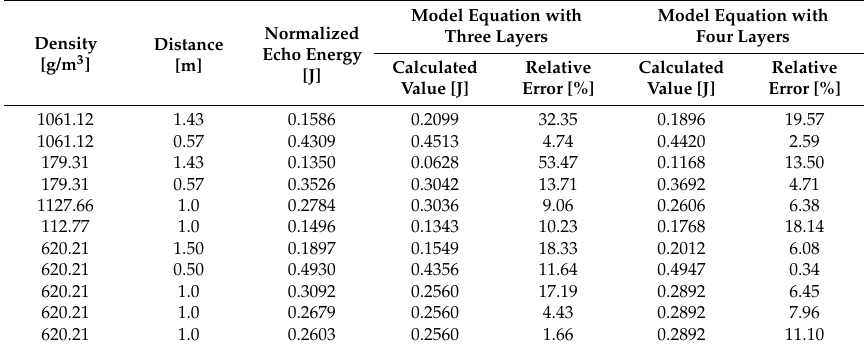
Table 7. Result of model equation contrast with 4 layers of